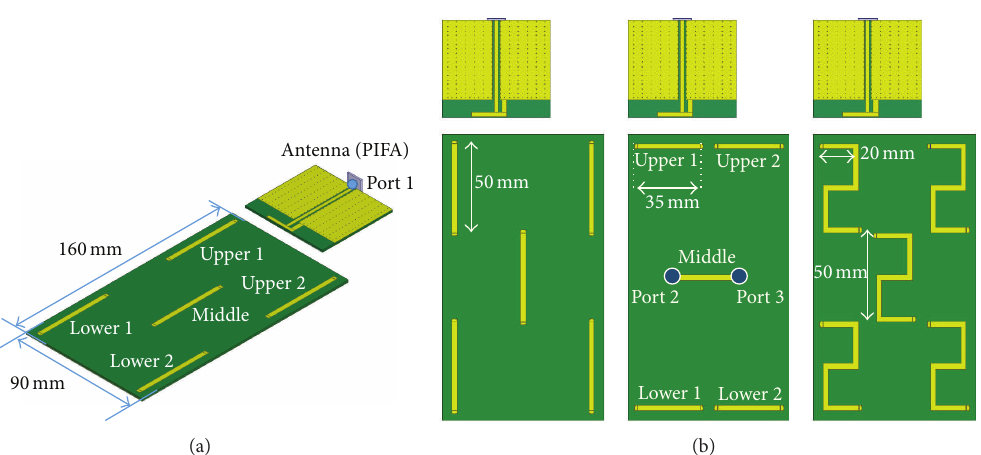
Figure 3: Antenna and transmission lines on the board. (a) Five positions of transmission lines and (b) three configurations of transmission lines on the board: vertical, horizontal, and bent. Port 1 is at the feeding port of the antenna and Port 2 and Port 3 are at the two ends of transmission lines.